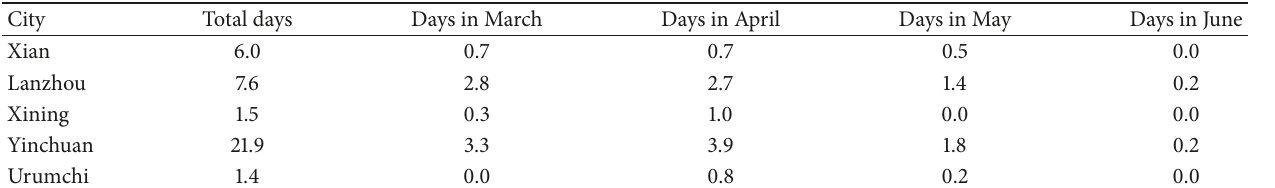
Table 2: The frequency of sandstorm at the five provincial capital cities in NWC from 2004 to 2012 (daya −1 ).